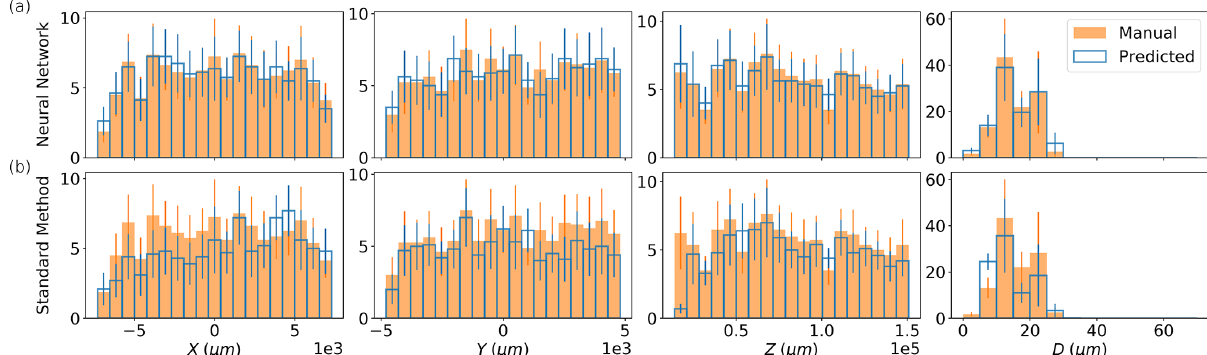
Figure 11. Histograms for x , y , z , and d are shown in each column, computed using the 10 testing HOLODEC holograms. The results for the standard method and the N SH = 1000 model are shown in (a) and (b) , respectively. The value of each bin and the error bar were computed by taking the mean and standard deviation across the 10